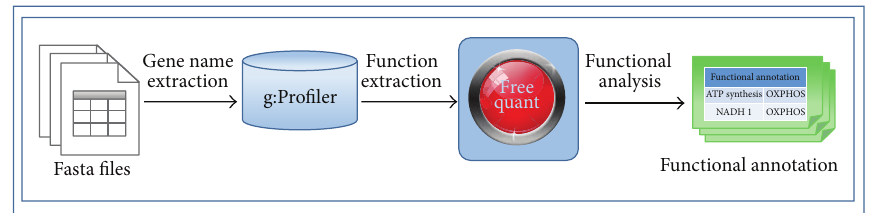
Figure 2: The functional analysis workflow. Gene name of each protein from IPI FASTA database was extracted by freeQuant. The list of gene name were inputted into g:Profiler via http://biit.cs.ut.ee/gprofiler/gconvert.cgi. A list of functional annotation results for each identified